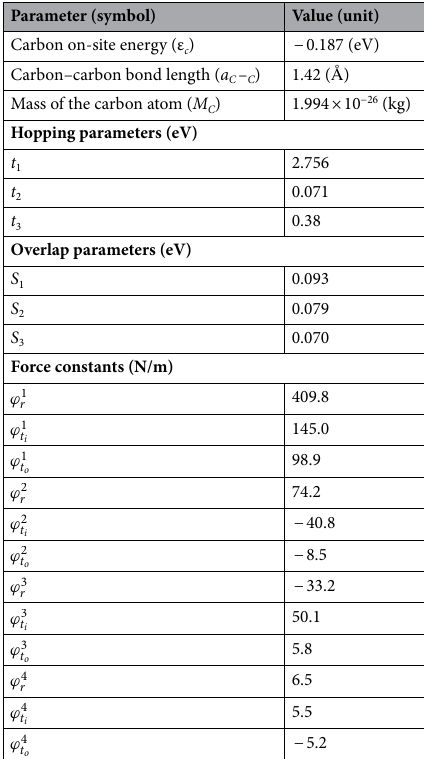
Table 1. Parameters involved in the TB, and FC